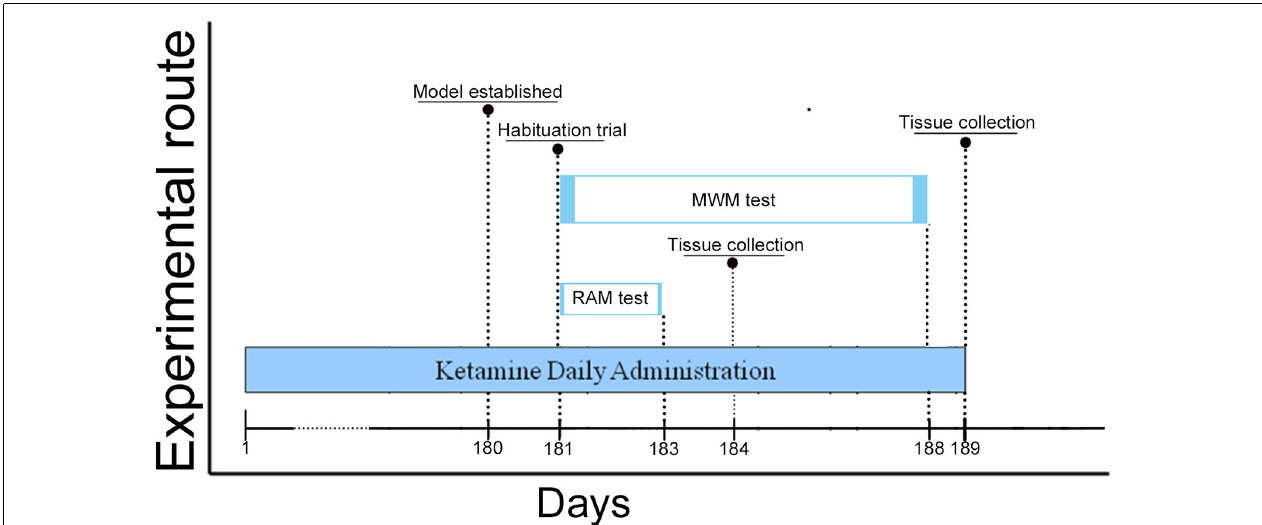
FIGURE 1 | Schedule of ketamine administration and behavioral assessment. Ketamine daily administration for 180 days (6 months). Morris Water Maze (MWM) test began on Day 181 and lasted until Day 188 of the study, the Radial Arm Maze (RAM) test started on Day 181 and lasted until on Day 183. We surveyed the sessions of escape latency (Day 183–187) and probe trials (Day 188) of mice to assess for spatial memory performance in the MWM test. Meanwhile, total errors and time spent to finish a session (Day 92–93 and Day 182–183) of mice in the RAM test were conducted to assess for spatial working memory performance. Animals were euthanized on Day 184 and 189, and brain tissue was collected in the − 80 ◦ C